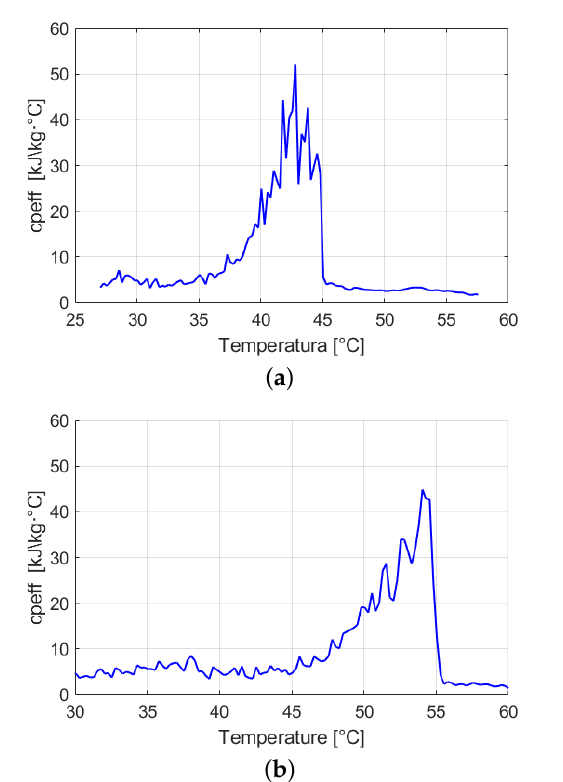
Figure 9. Effective thermal capacity in terms of the temperature evaluated by the T-history method ( a ) RT45; and ( b )